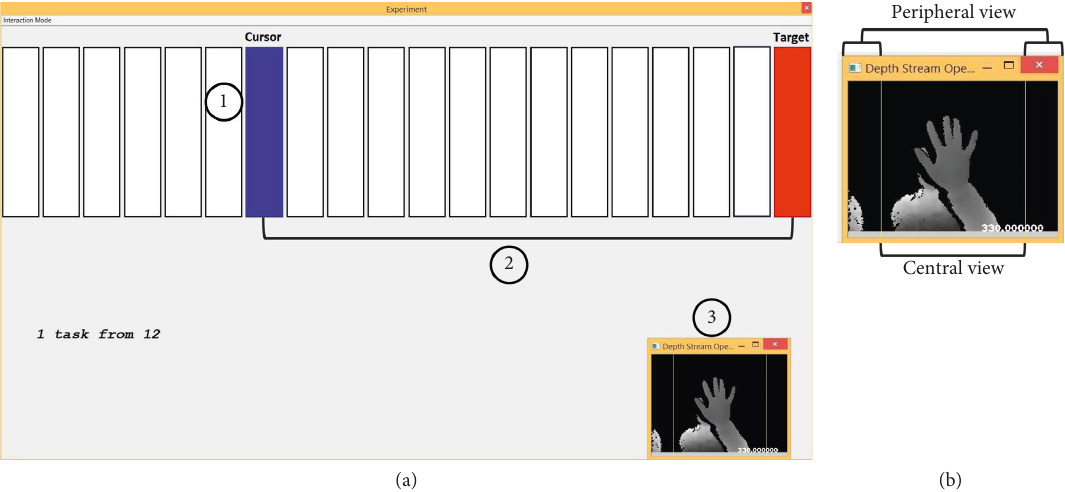
Figure 2: (a) Screenshot of the experiment software prototype: (1) engaged bar changed its color from gray to blue; (2) translation distance; and (3) depth image. (b) Visualization of the depth view with its three parts: central view in the middle and peripheral views on the sides.